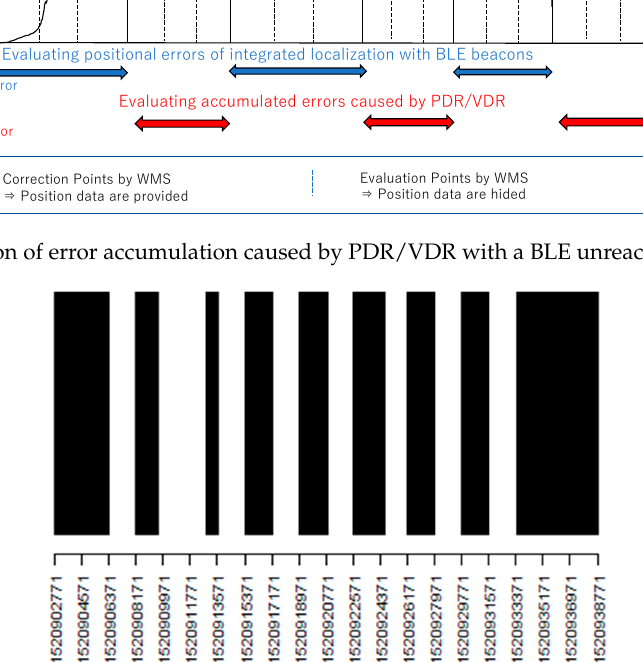
Figure 13. An example of BUPs defined for a test data.